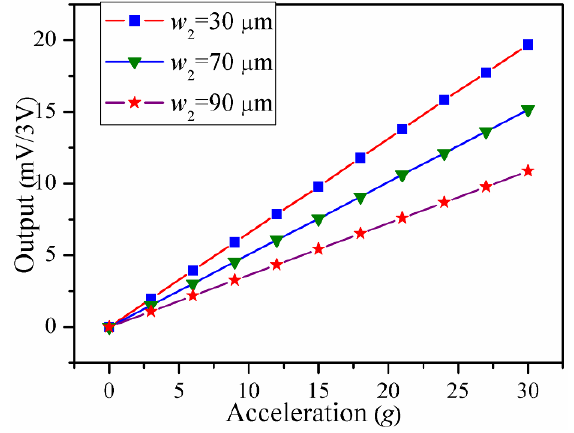
Figure 9. The output voltages versus the accelerations.